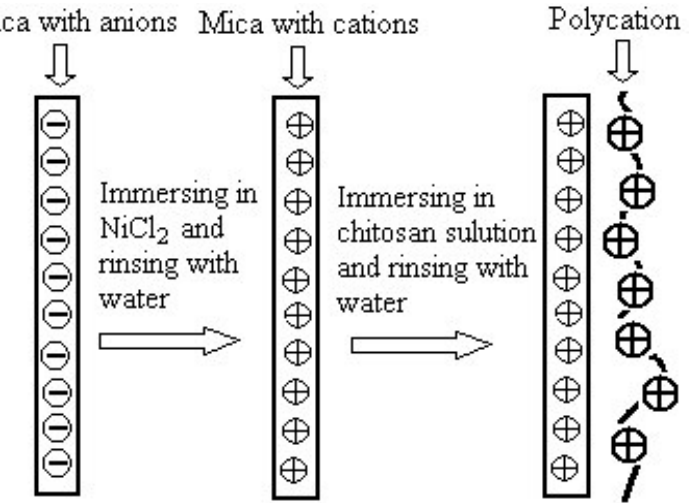
Figure 9. Sketch illustration of self-assembly strategy of chitosan on NiCl